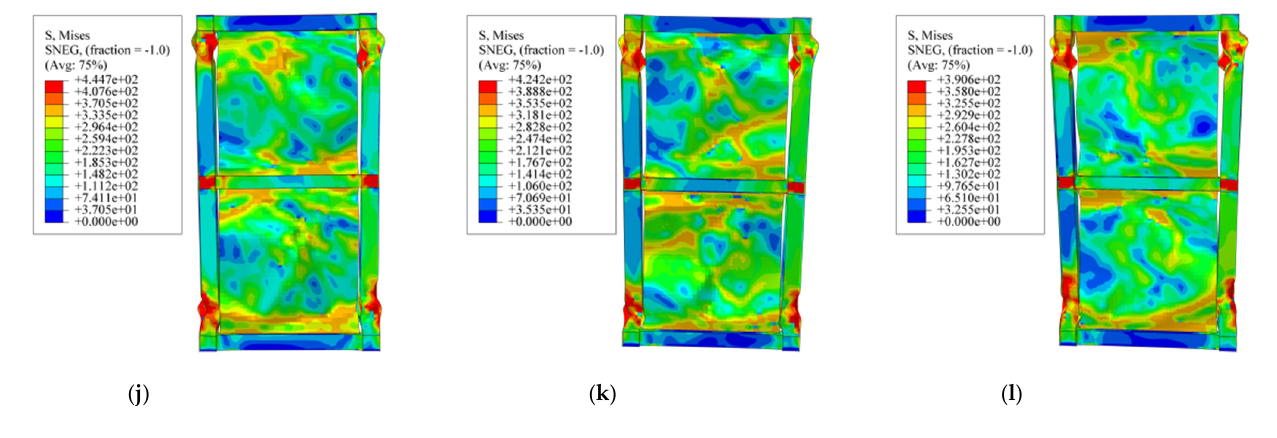
Figure 15. Stress distribution of FEM results for different corrosion times: ( a ) corroded FSPSW for 20 d; ( b ) corroded FSPSW for 60 d; ( c ) corroded FSPSW for 120 d; ( d ) corroded OSPSW for 20 d; ( e ) corroded OSPSW for 60 d; ( f ) corroded OSPSW for 120 d; ( g ) corroded VSSPSW for 20 d; ( h ) corroded VSSPSW for 60 d; ( i ) corroded VSSPSW for 120 d; ( j ) corroded BSPSW for 20 d; ( k ) corroded BSPSW for 60 d; ( l ) corroded BSPSW for 120 d.